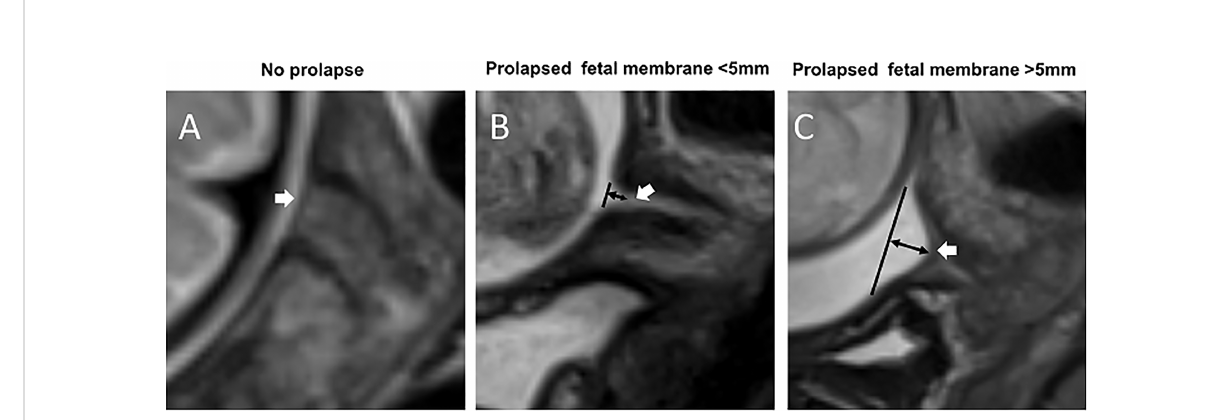
FIGURE 1 Prolapsed fetal membrane. T2WI of the cervix in the sagittal view. (A) A fetal membrane with no prolapse at 32 weeks ’ gestation. (B) A prolapsed fetal membrane <5 mm at 32 weeks. (C) A prolapsed fetal membrane >5mm at 28 weeks. White arrows indicate the fetal membrane; black lines indicate the position of the internal cervical os, and black double arrows indicate the extent of membrane